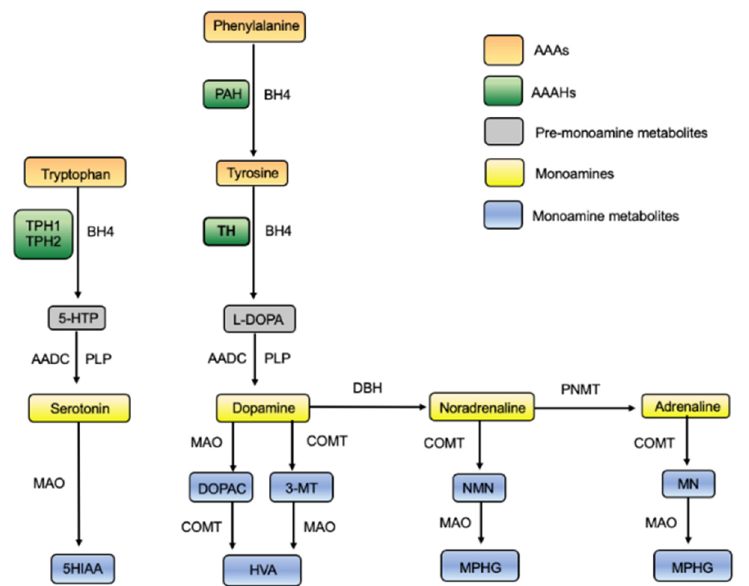
Figure 1. Simplified overview of the biosynthesis and catabolism of serotonin and the catecholamines. Note that different parts of these processes take place in different tissues (see text for details). Abbreviations: 3-MT, 3-methoxytyramine; 5-HTP, 5-hydroxytryptophan; 5HIAA, 5-